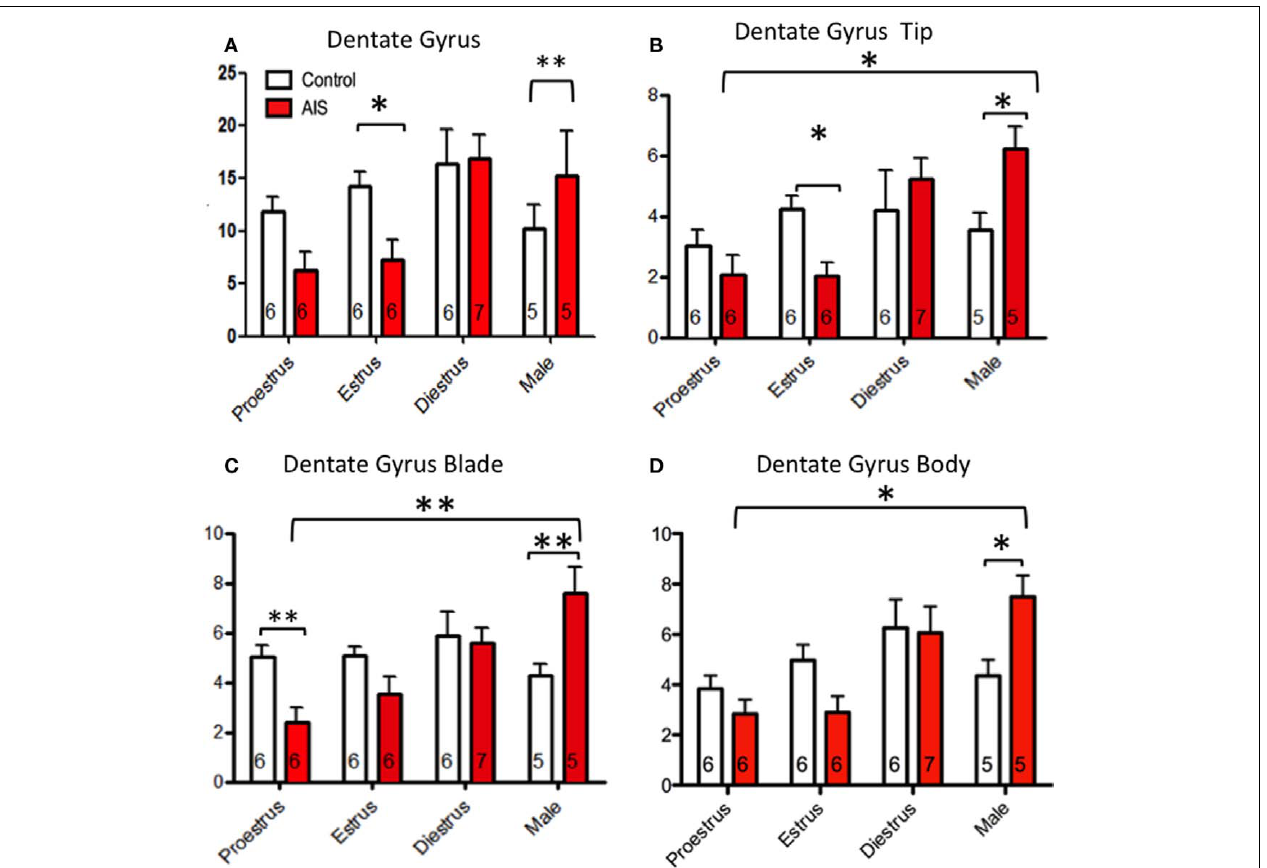
controls whereas AIS estrus females had less pMOR-ir compared to their controls (A) .When analyzed as separate subregions however, additional differences were emerged. AIS significantly increased pMOR-ir in males compared to proestrus females in the tip (B) , blade (C) , and body (D) of the DG. AIS significantly decreased pMOR-ir in proestrus females within the DG blade (B) . * p < 0.05, ** p <